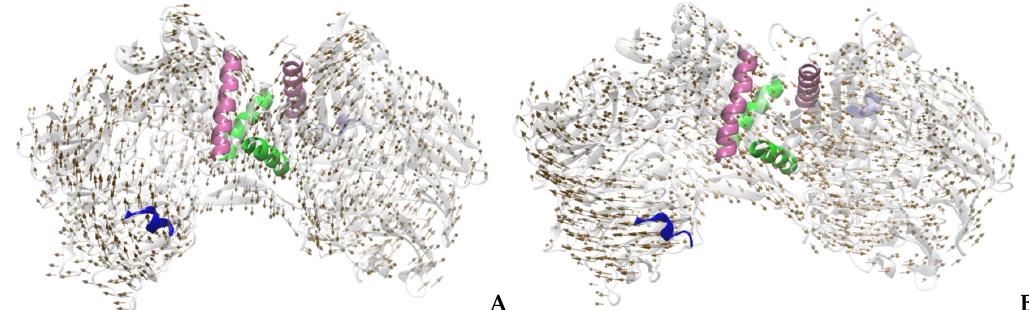
Figure 2. Indicative vectors of the direction of movement of the DPP-4 enzyme: ( A ) this figure corresponds to mode 7 (twisting motion between the chains); ( B ) this figure corresponds to mode 8 (active site exposure). The pink region is formed by Glu91, Asn92, Ser93, Thr94, Phe95, Asp96 and Glu97; blue is: Ser745, Thr746, Ala747, His748, Gln749, His750, Ile751, Tyr752, Thr753, His754, Met755, Ser756, His757, Phe758, Ile759, Lys760, Gln761, Cys762 and Phe763; and the green region is formed by: Phe713, Gln714, Gln715, Ser716, Ala717, Gln718, Ile719, Ser720, Lys721, Ala722, Leu723, Val724, Asp725 and Val726.